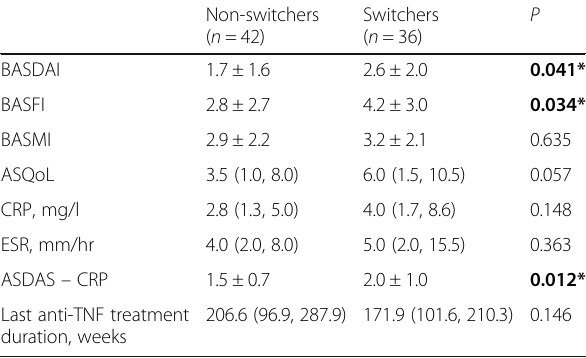
Table 1 Patients characteristics at baseline Variable